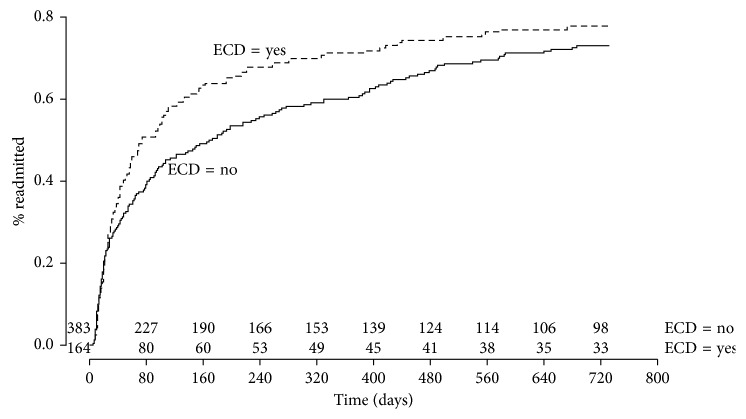
Fraction of patients hospitalized over the course of two years after transplant, stratified by whether the patient received an ECD kidney. Time is in days. The table along the X-axis shows raw counts of patients at risk for hospitalization at each time point.